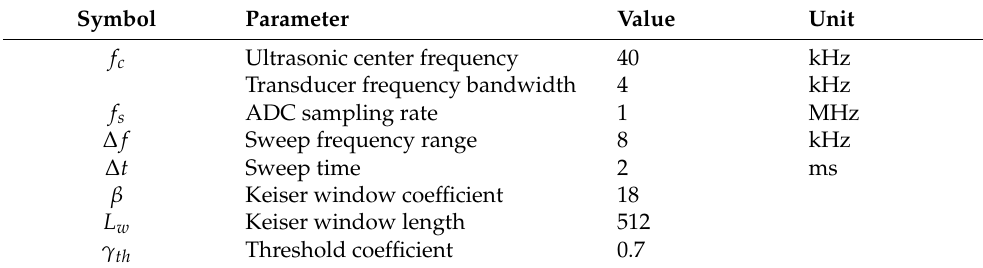
Figure 6. Ultrasonic transmission/reception test environment: ( a ) ultrasonic transducer, ( b ) experi- ment environment. Table 1. Experimental parameters.